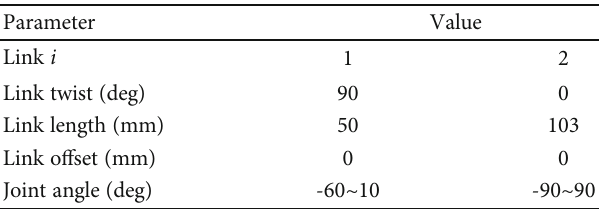
Table 2: Standard DH parameters of the manipulator.